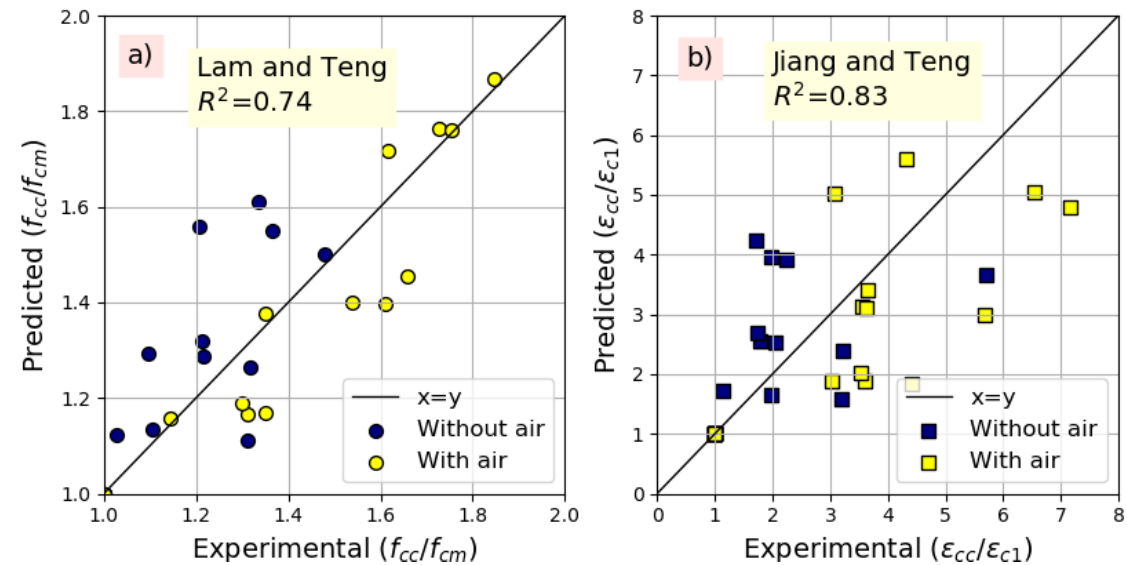
Figure 12. Predicted and experimented: ( a ) ultimate strength, ( b ) ultimate strain. The model given by Equation (13) was adopted to describe the full stress–strain be- havior of both unconfined and FRP-confined NAC and RAC. This model proposed ini- tially by Popovic and adopted later by Mander [42] was modified in the work of Ghorbel et al. [43] to account for the presence of RCA for unconfined concrete. It requires only the knowl- edge of the compressive strength ( f cm of f cc ); then, the tangent elastic modulus can be calculated based on the mean compressive strength and the replacement ratio according to Equation (14). The peak strain for unconfined concrete can be calculated according to Equation (15), where it was found that this strain depends only on the compressive strength regardless of the replacement ratio [3,43].